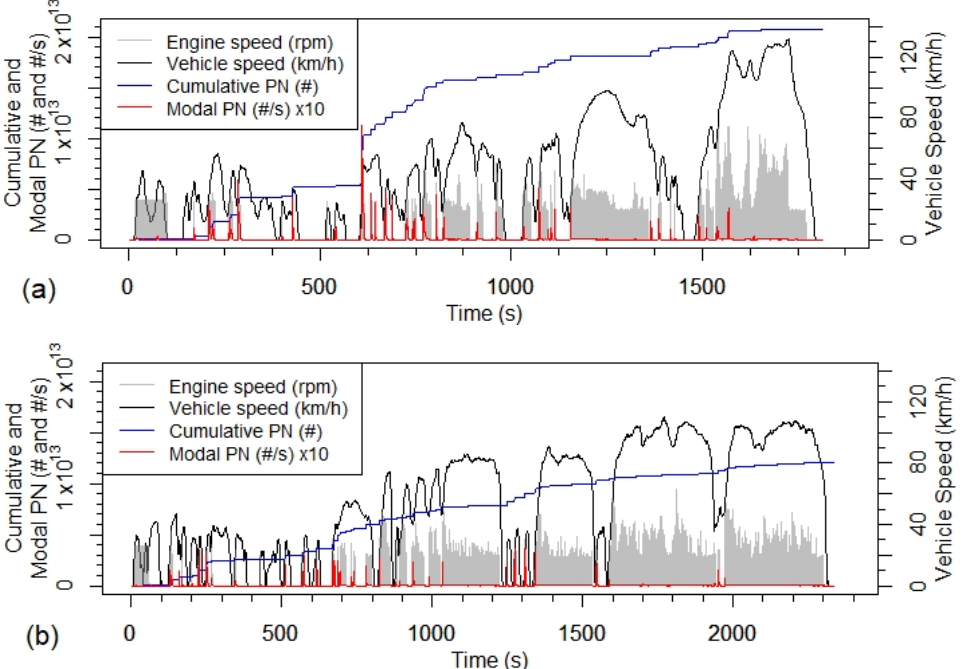
Figure 6. Average PN emissions per kilometre across the WLTC and RDE test cycles. Individual phase and total cycle results are given, along with the Euro 6 PN limit of 6 × 10 11 #/km (dotted line). Error bars represent the standard error of the repeats (two tests for WLTC, three tests for RDE).